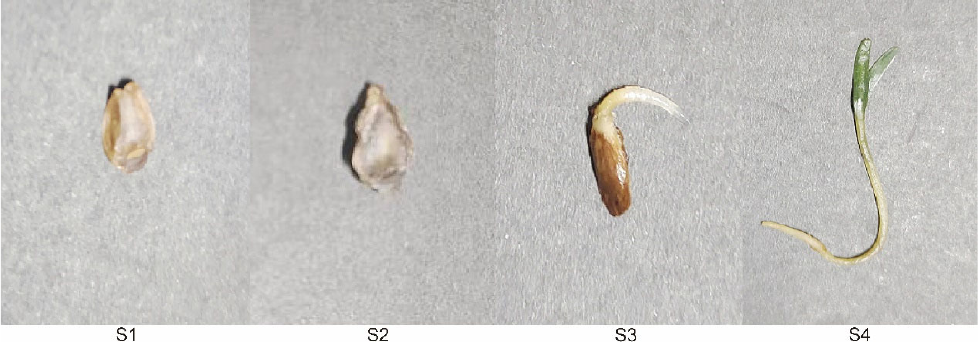
Figure 1. Chinese fir seeds in the four germination stages (imbibition stage (S1), preliminary stage (S2), emergence stage (S3), and germination stage (S4)).